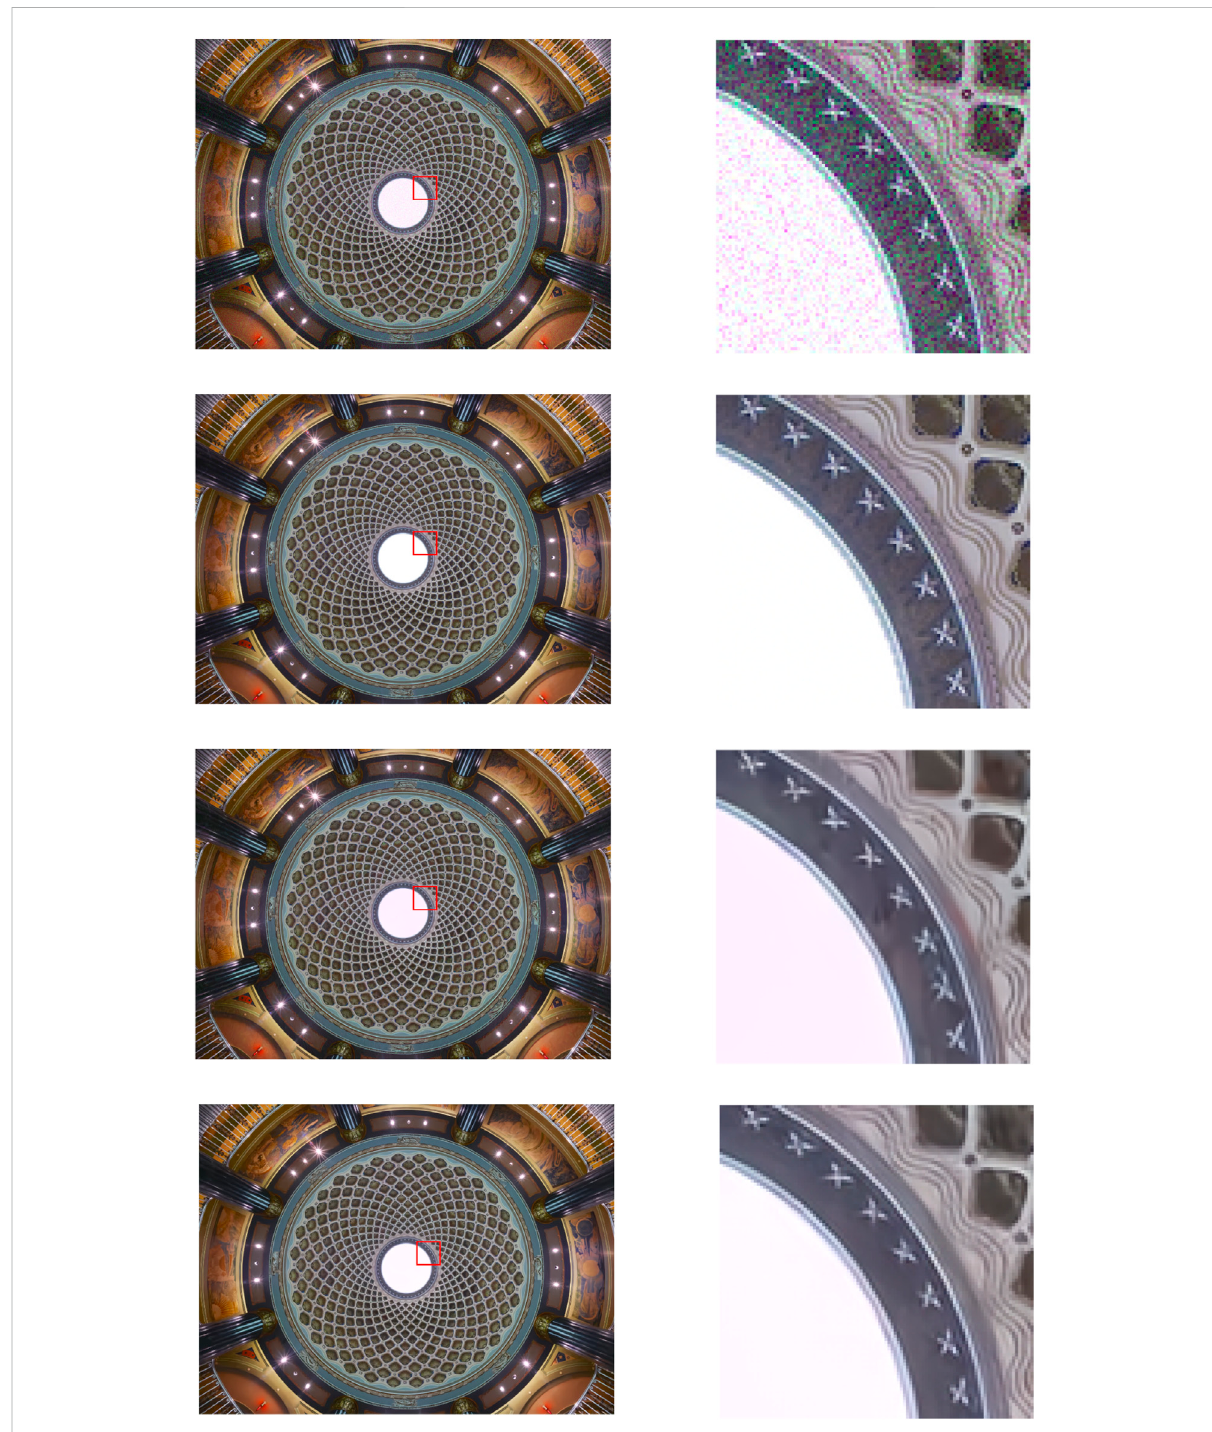
FIGURE 11 An example of denoised images. Top to Bottom: noisy image, clean image, Denoised: Cheng + FFDNet-clip (bpp = 0.57), Denoised: proposed (bpp = 0.55). Images in the right column show the red square in the left